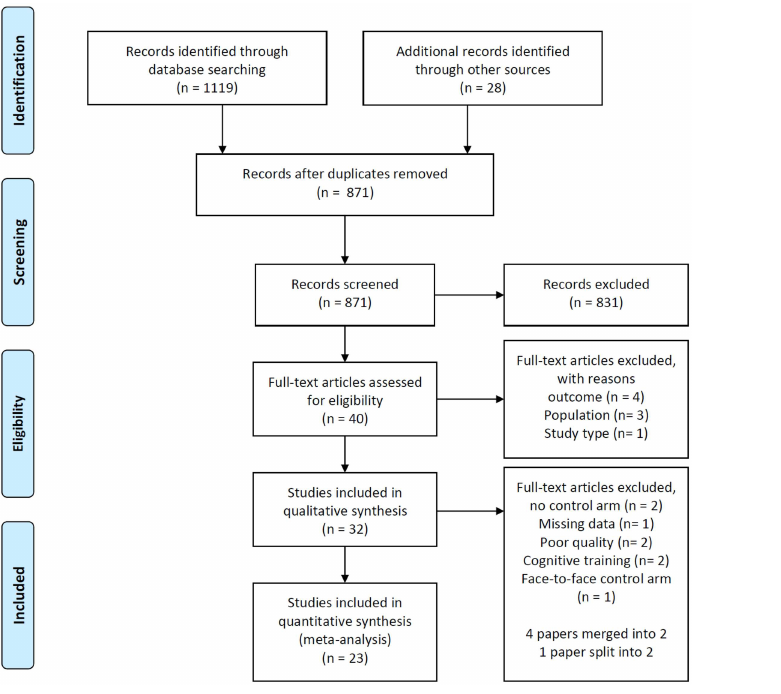
Fig 1. Flow chart of studies